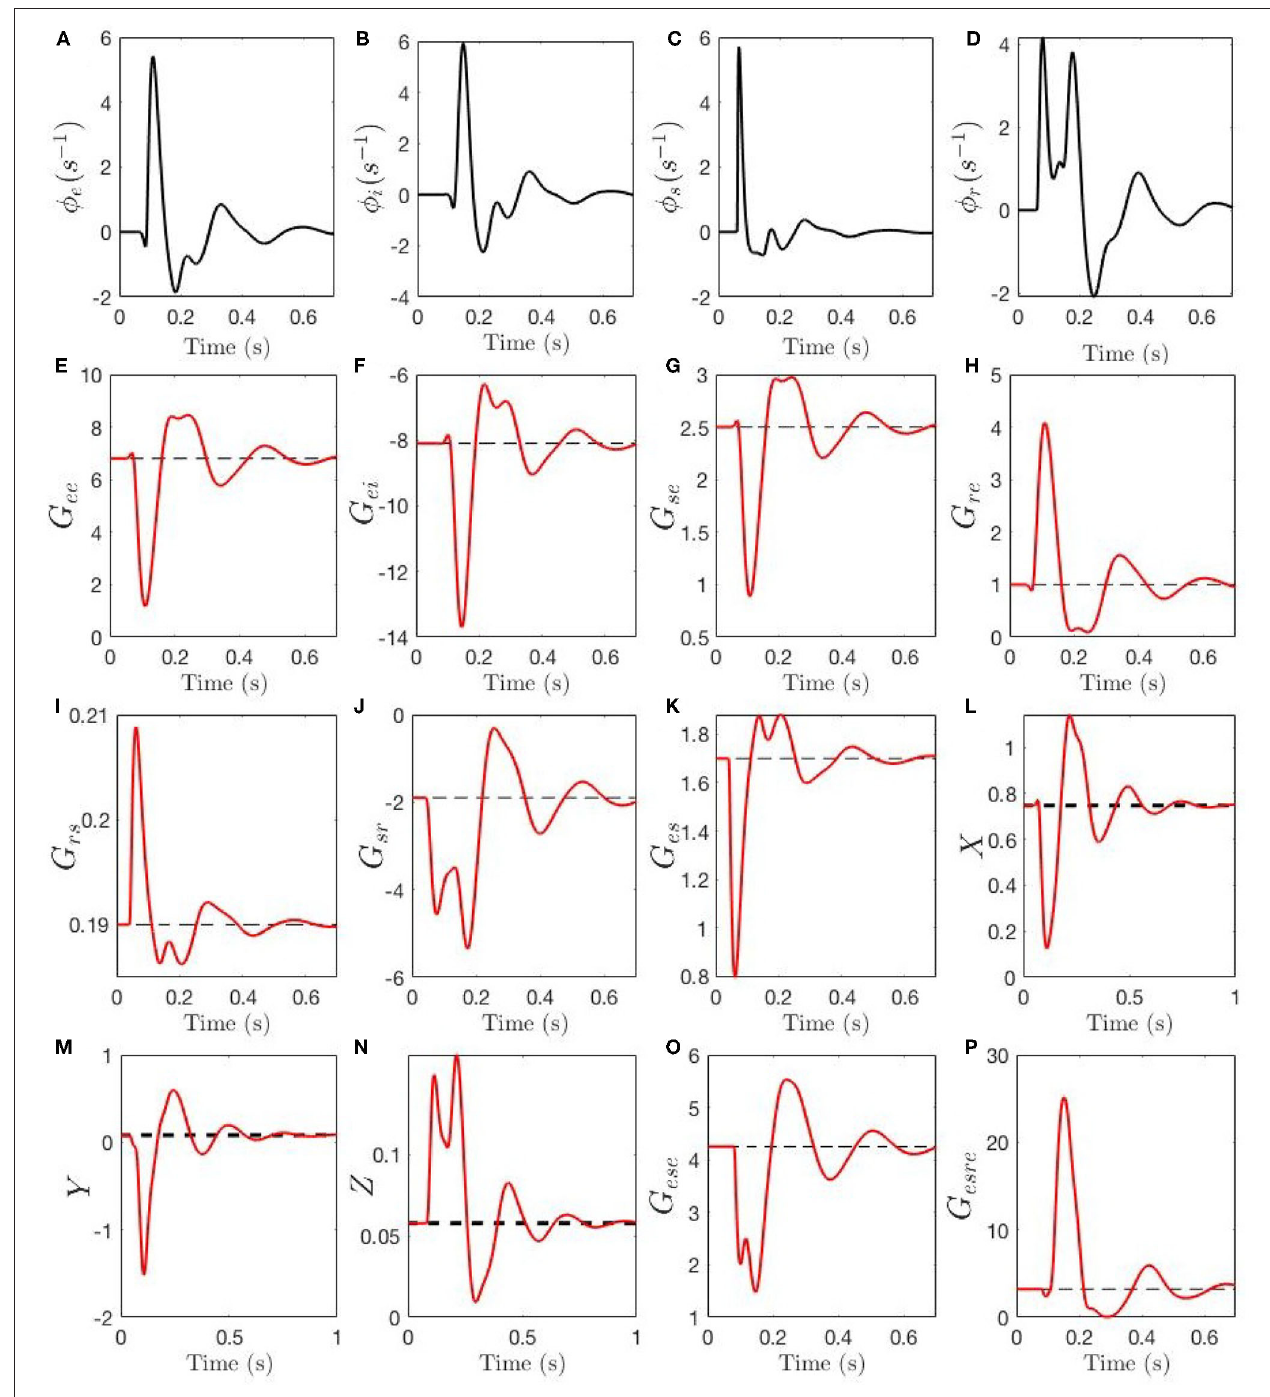
FIGURE 7 | Temporal dynamics of corticothalamic gains during an ERP event. The steady-state G (0) ab of each gain is shown by a black dashed line, the adjustment due to local feedback G (1) ab around the steady-state and the total gain magnitude G ab is shown by red line. Evoked time evolution of the following quantities are shown: (A) φ e . (B) φ i . (C) φ s . (D) φ r . (E) G ee . (F) G ei . (G) G se . (H) G re . (I) G rs . (J) G sr . (K) G es . (L) X . (M) Y (N) X . (O) G ese . (P) G esre .